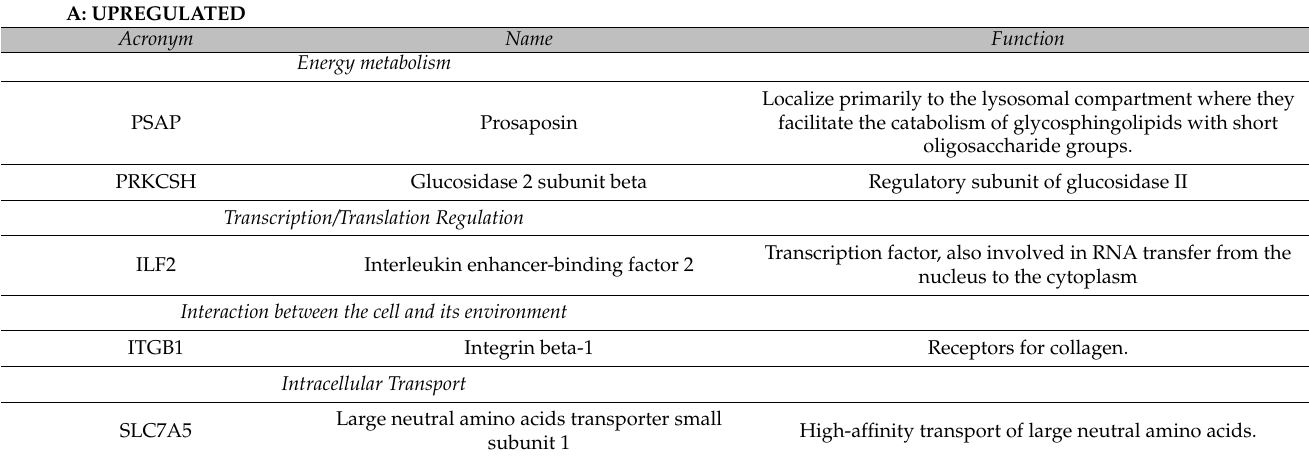
Table 5. Proteins which expression was altered between H12 and